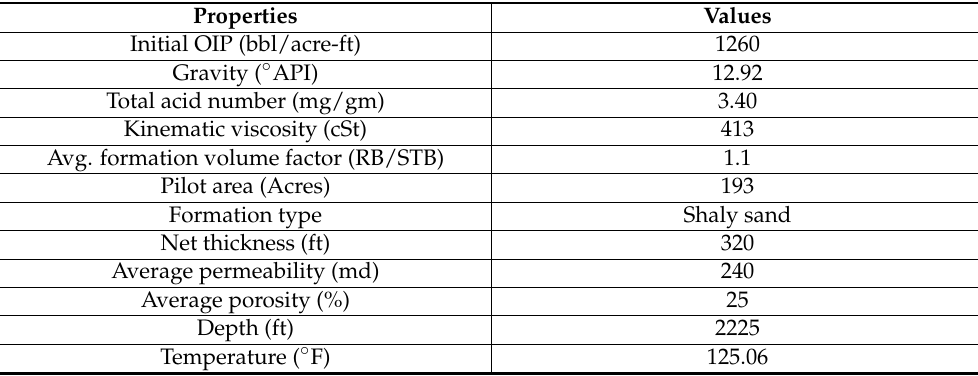
Table 4. Field and fluid properties of the Wilmington field,